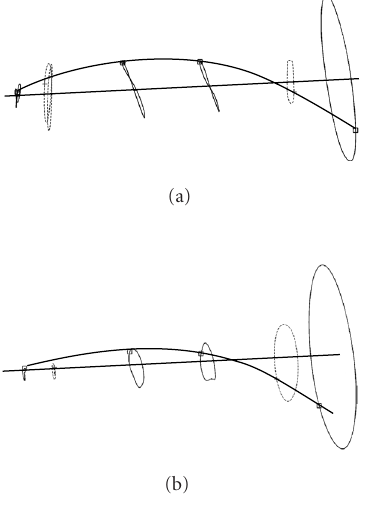
Figure 11: The deformation of the rotor for the first backward and forward critical speeds: (a) backward mode and (b) forward mode.